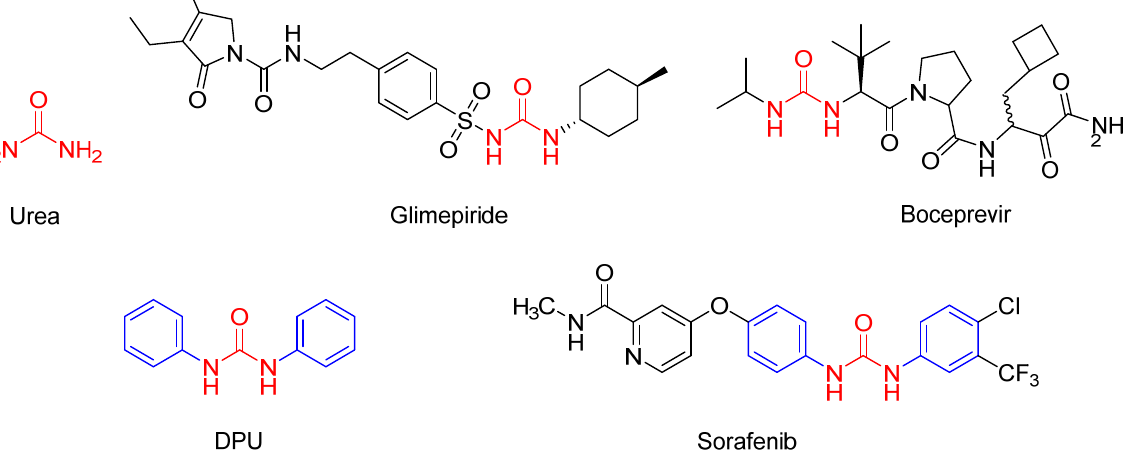
Figure 2. The structures of Urea, Glimepiride, Boceprevir, DPU, and Sorafenib.